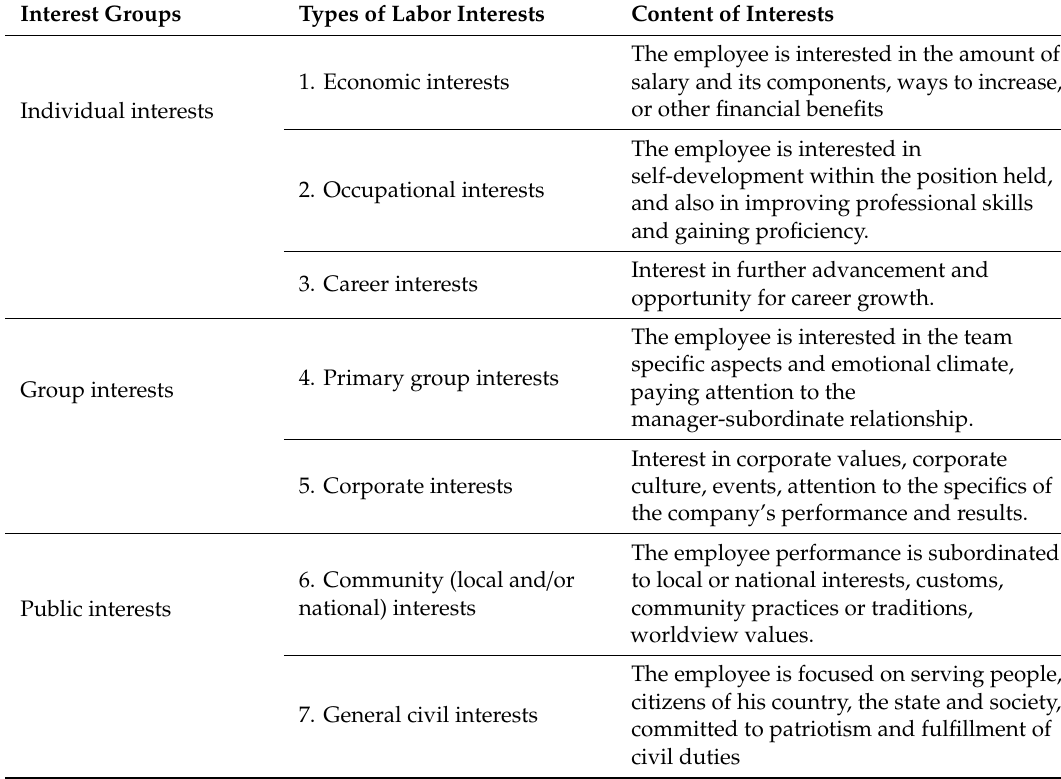
Table 1. Types and content of labor